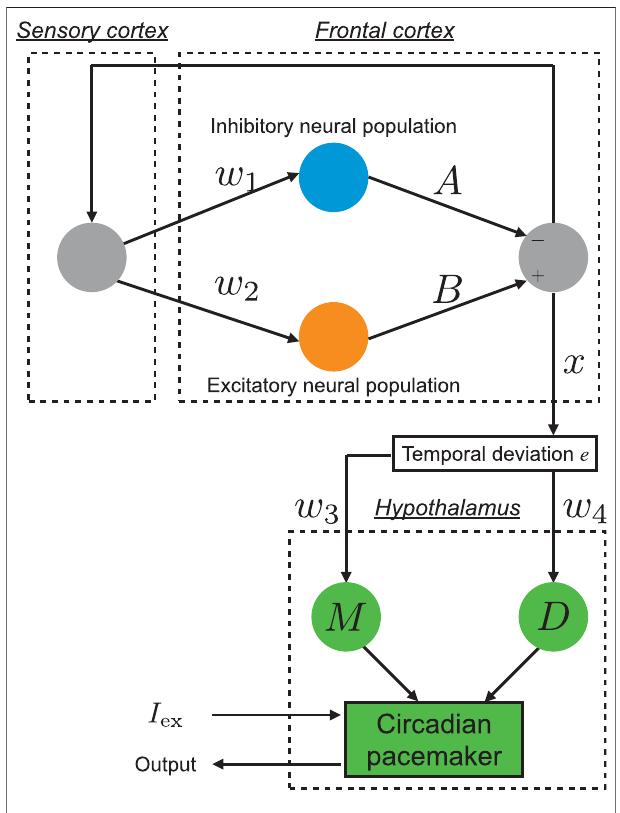
FIGURE 1 | Overview of the neural system proposed by Hadaeghi et al. (2016), which is composed of the frontal cortex and hypothalamus to reproduce circadian